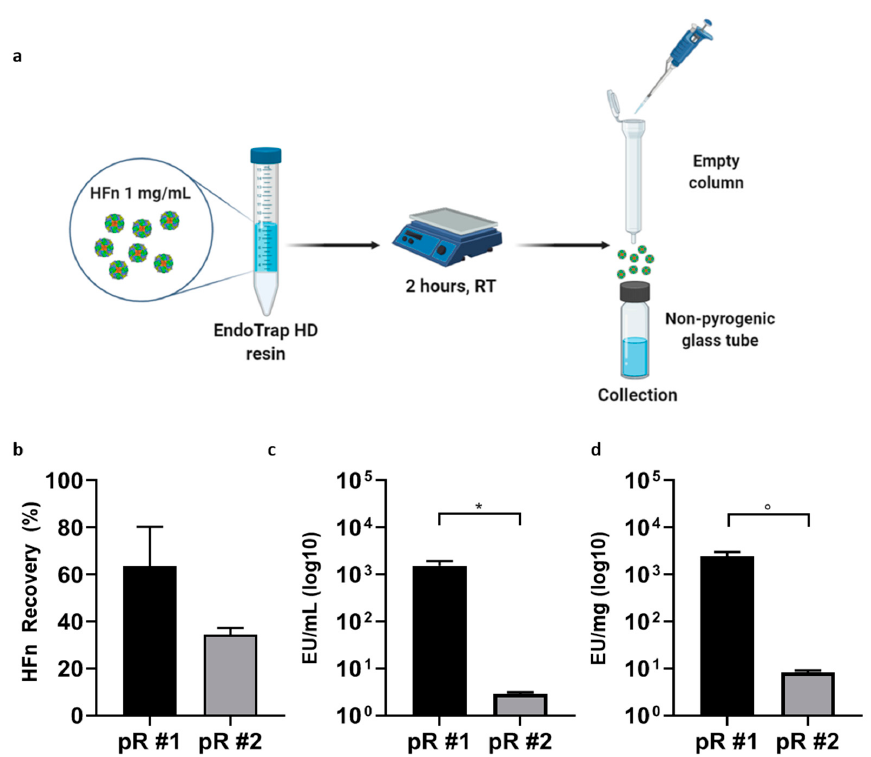
Figure 2. Purification Strategy using Endotrap HD resin in batch mode. HFn (1 mg/mL) was incubated with the resin for 2 h at room temperature (RT) and eluted using an empty column, where the resin was trapped ( a ). Incubation has been repeated once or twice, with new resin (pR#1 and pR#2 respectively). HFn recovery after one (black) or two cycles of incubation with resin (gray) was calculated by absorbance reading ( b ); ETX levels have been obtained by LAL test ( c, d ). Results are reported as average ± S. D. of 4 independent experiments. Statistical significance: * p = 0.0314, ° p = 0.0315.